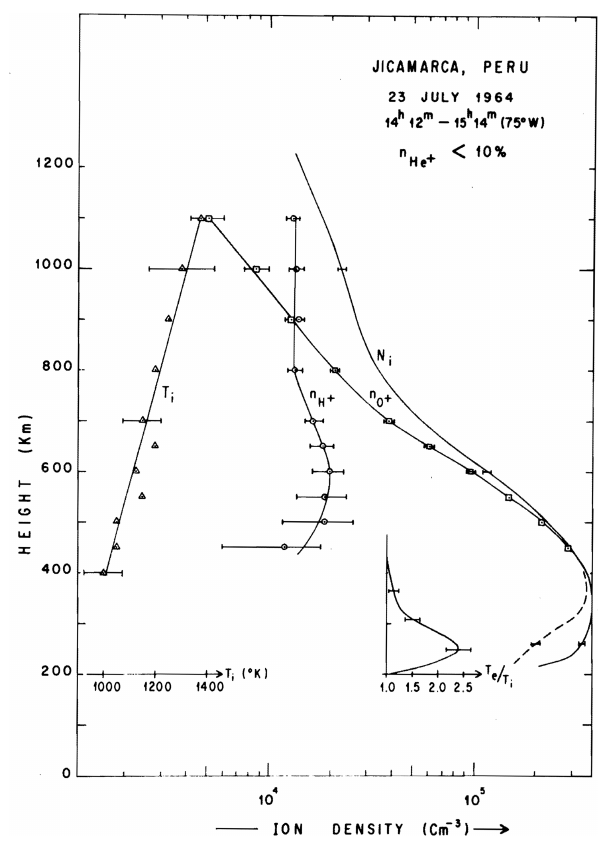
Figure 21. Plasma density, ionic composition, temperature, and T e /T i profiles of the ionosphere above Jicamarca, measured on 23 July 1964 (reproduced from Farley and Bowles,